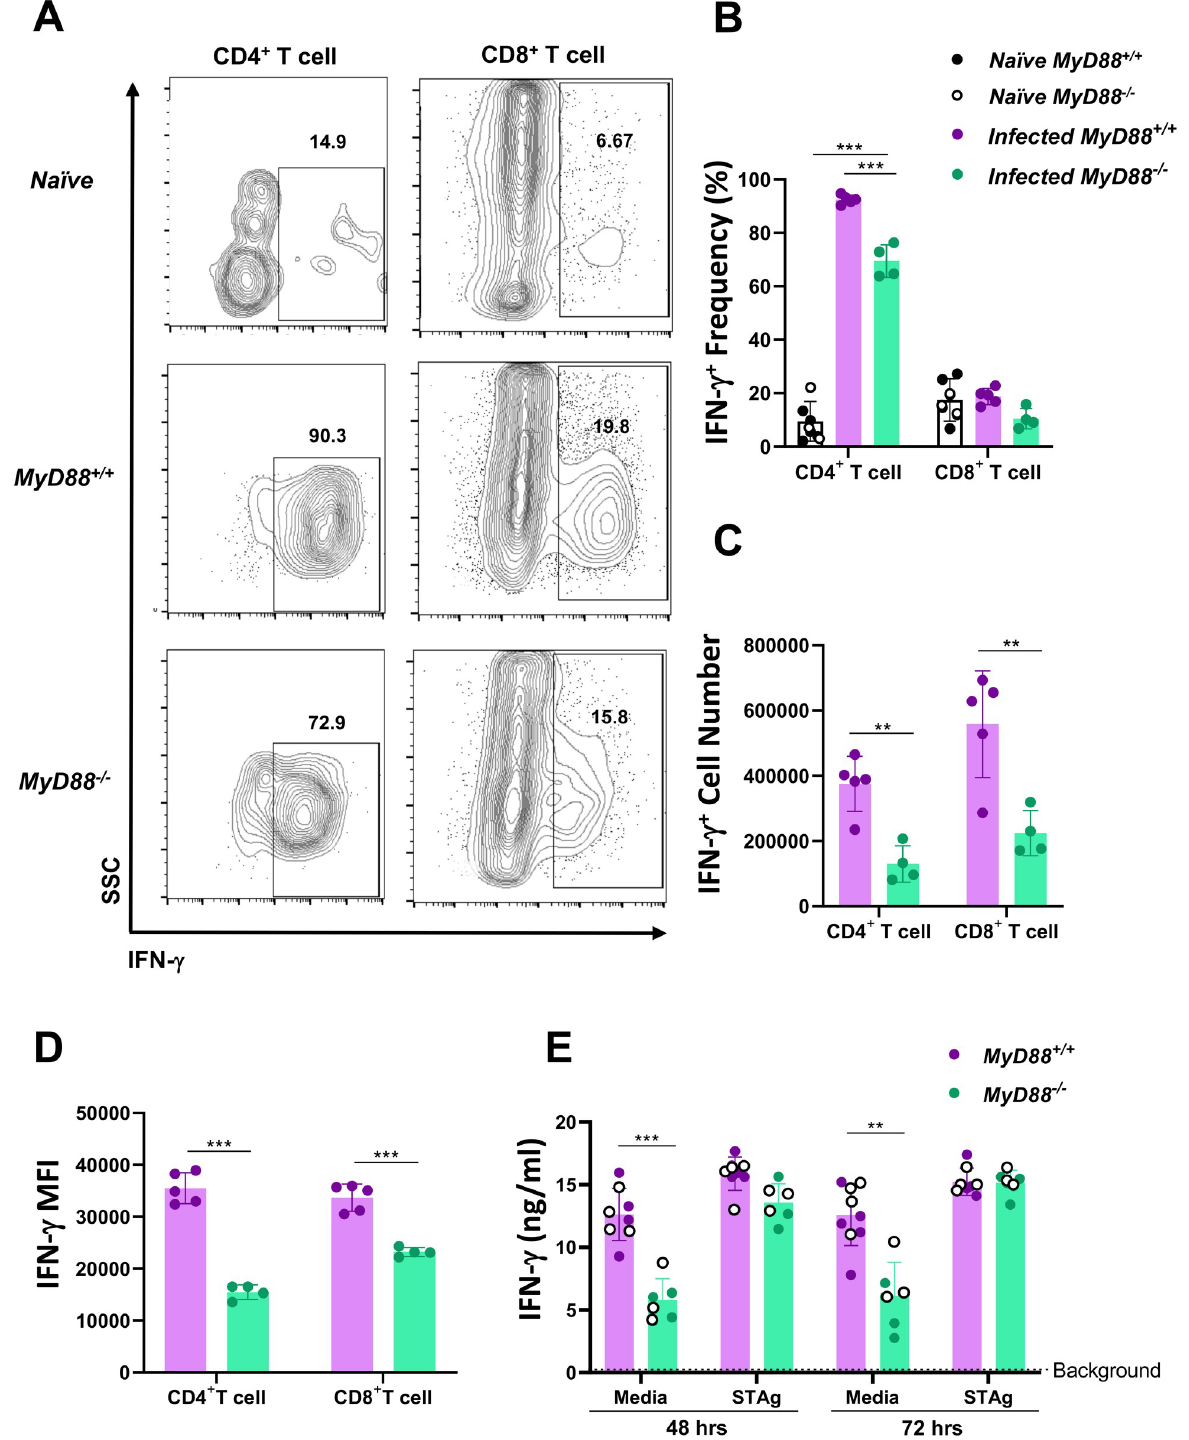
Fig 3. T . gondii triggers a vigorous MyD88-independent IFN- γ response in the small intestine. Lamina propria cells were collected from na ï ve and day 7 infected MyD88 +/+ and MyD88 -/- mice, and T lymphocyte IFN- γ production was assessed by flow cytometry. (A) Representative contour plots showing T cell IFN- γ expression in MyD88 WT and KO mice. Numbers indicate the percentage of cells falling within gates. Naïve shows the responses of noninfected WT and KO mice. (B) The frequency of IFN- γ + cells and (C) total number of IFN- γ + T cells over multiple mice. (D) Mean fluorescence intensity (MFI) of IFN- γ positive CD4 + and CD8 + T cell populations in the LP. (E) IFN- γ production during ex vivo culture of LP cells